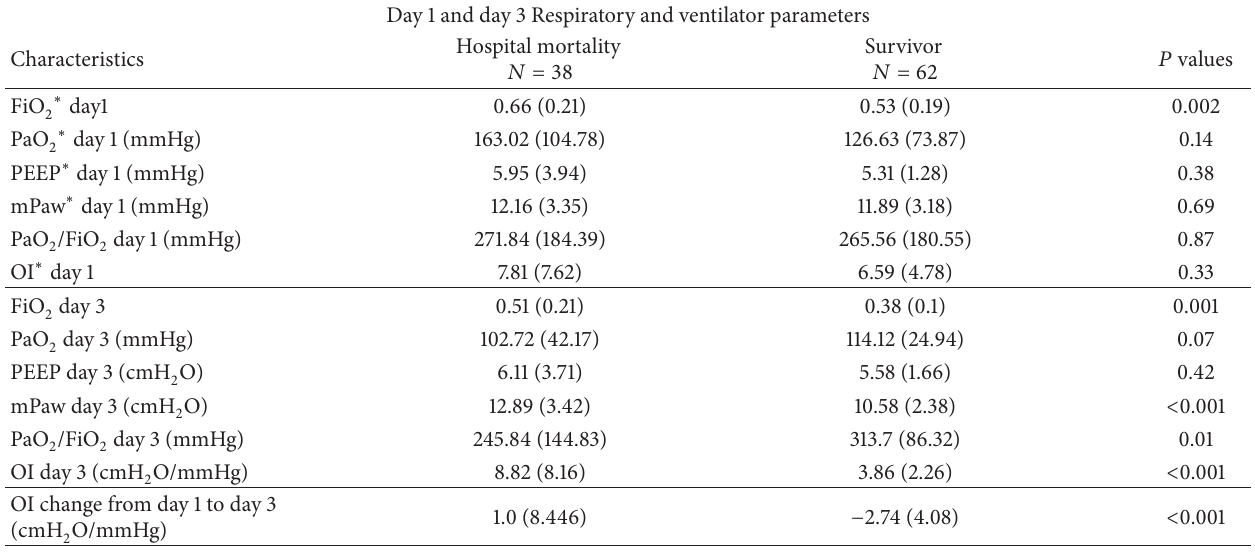
Table 4: Respiratory and ventilator parameters of survivors and nonsurvivors on day 1 and day 3 of mechanical ventilation # .